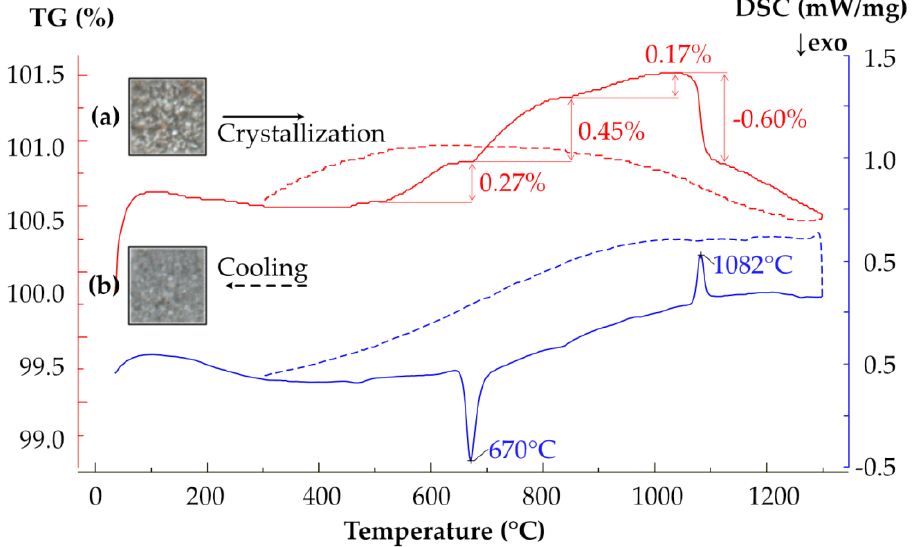
Figure 9. TG and DSC curves of metamict brannerite heated to 1300 ◦ C. Photographs of the powder sample before (a) and after (b) thermal analysis are shown (field of view of each frame is 0.5 × 0.5 mm). Curves obtained during the cooling are shown by the dotted lines.